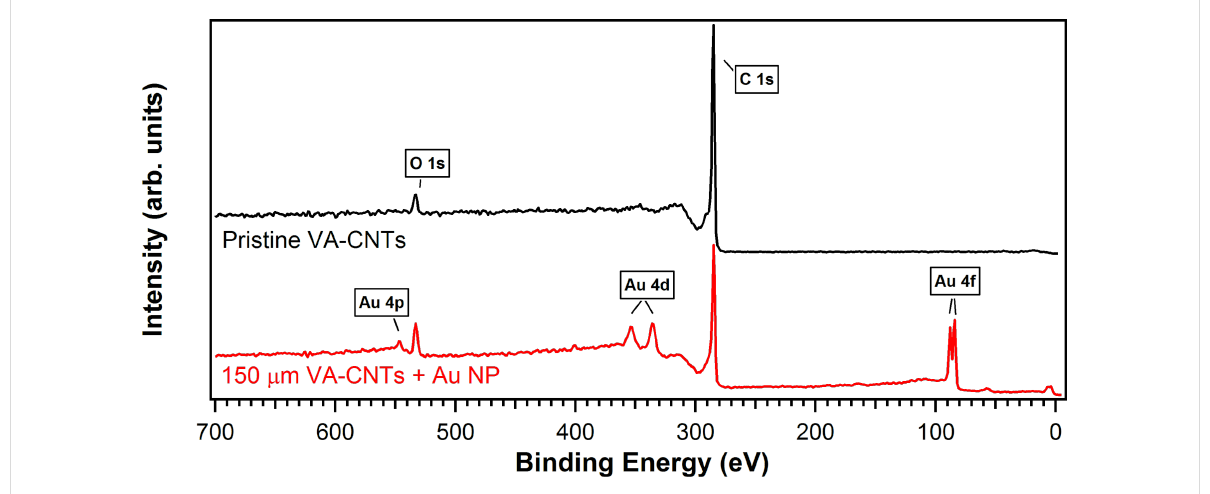
Figure 6: XPS survey spectra for pristine VA-CNTs (top, black line) and 150 µm-long VA-CNTs decorated with 6 nm-diameter gold nanoparticles on top (bottom, red line).